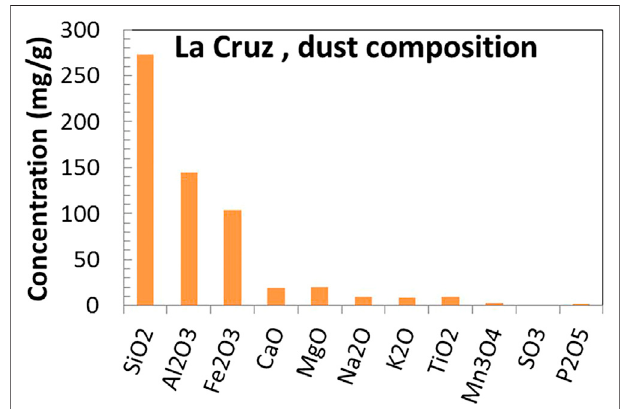
FIGURE 5 | Composition of soil dust in La Cruz, estimated using the method described in the